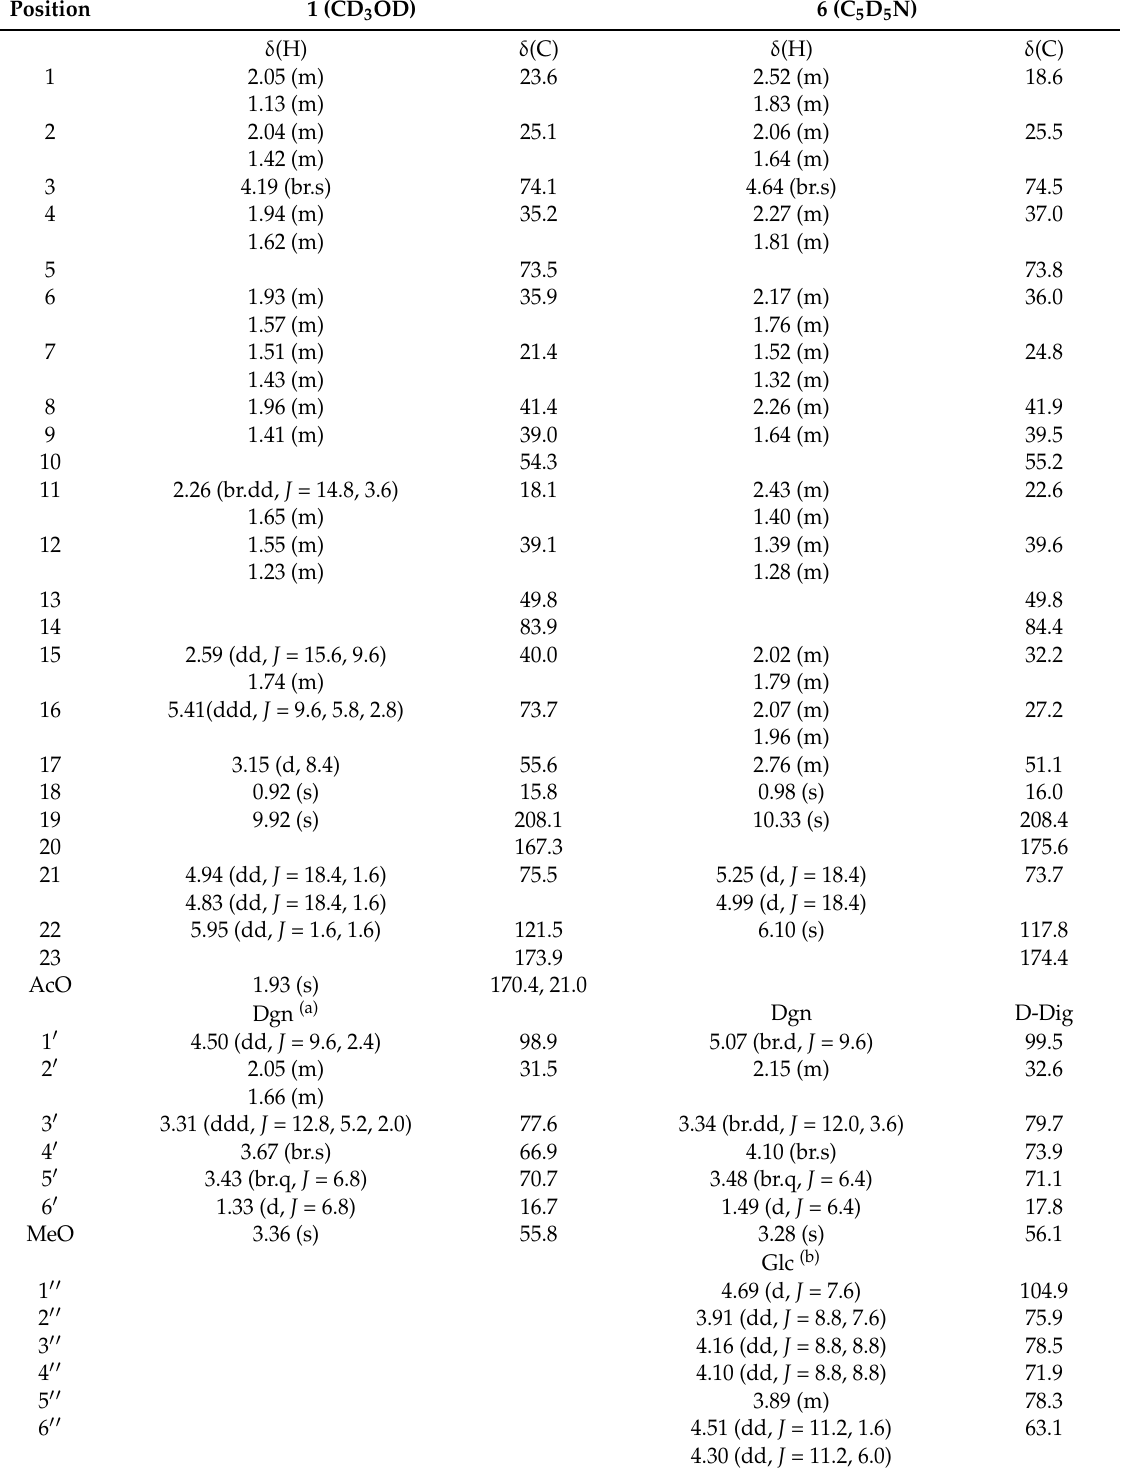
Table 1. 1 H- and 13 C-NMR Data (400 and 100 MHz, resp.) of compounds 1 and 6